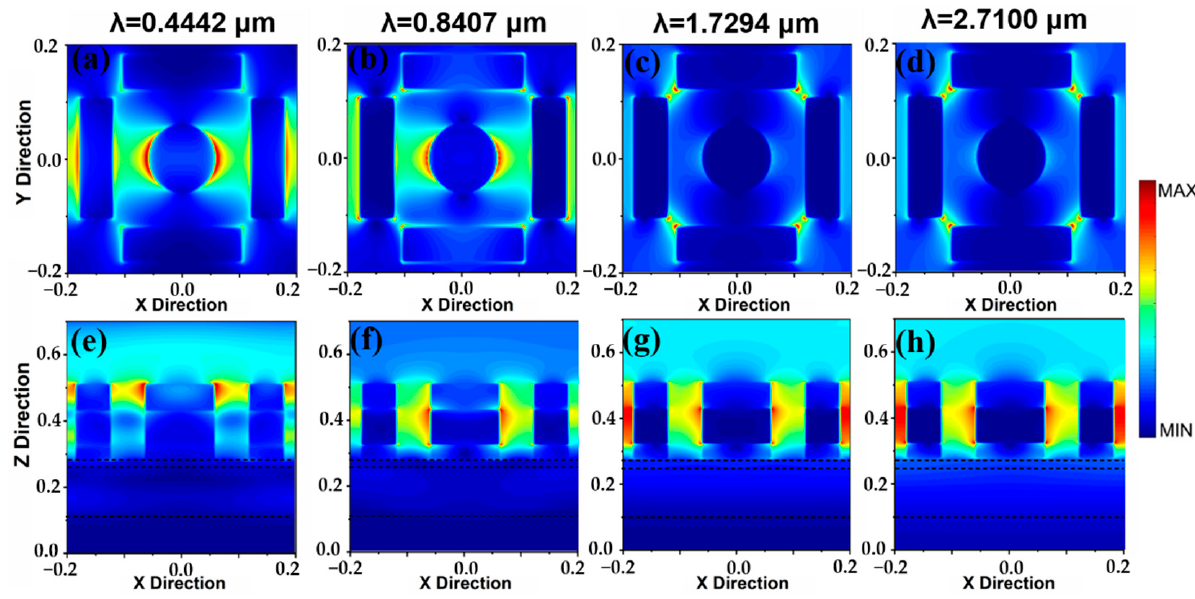
Figure 3. Simulated electric field diagrams. ( a ) X-Y plane at λ = 0.4442 μ m; ( b ) X-Y plane at λ = 0.8407 μ m; ( c ) X-Y plane at λ = 1.7294 μ m; ( d ) X-Y plane at λ = 2.7100 μ m; ( e ) X-Z plane at λ = 0.4442 μ m; ( f ) X-Z plane at λ = 0.8407; ( g ) X-Z plane at λ = 1.7294 μ m; ( h ) X-Z plane at λ = 2.7100 μ m